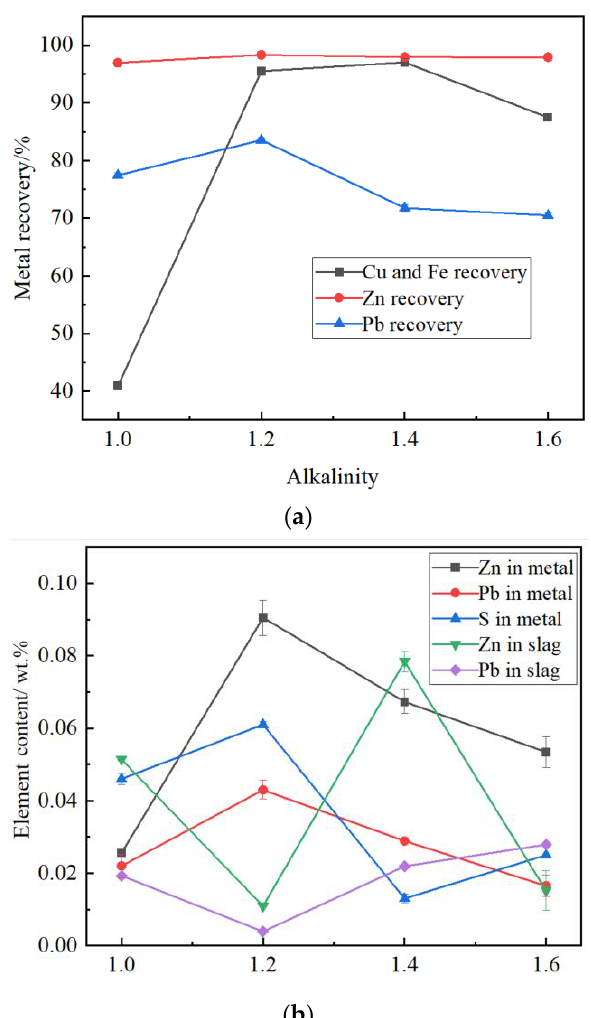
Figure 10. The effect of alkalinity on the reduction of slag ( a ): metal recovery, ( b ): element content in metal and slag.